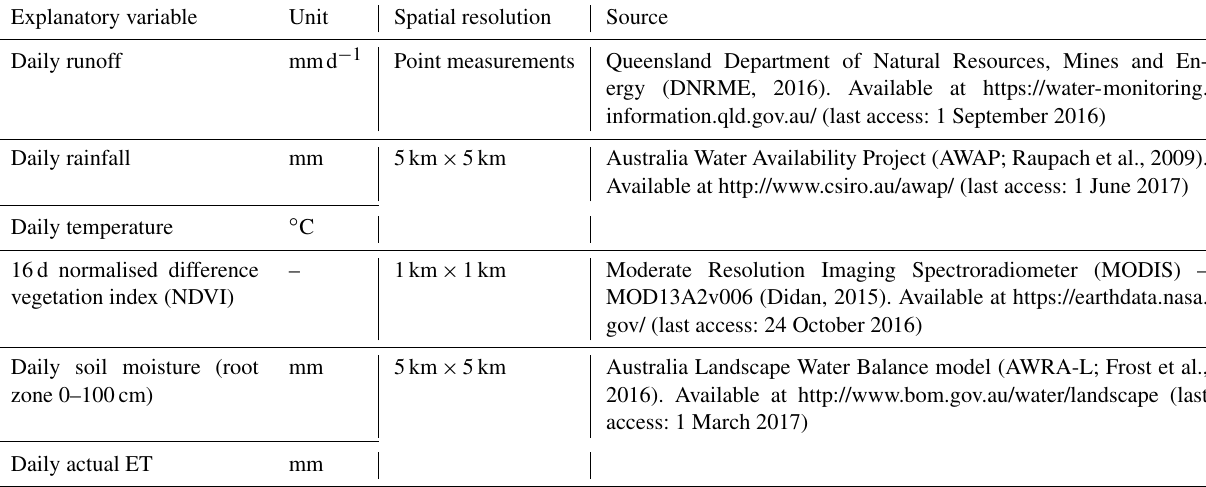
Table 2. Explanatory variables and their data